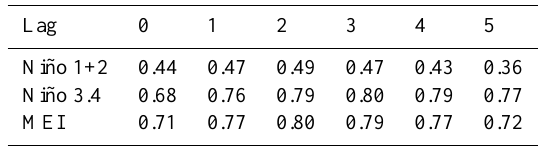
Table 4. Coefficient of determination ( r 2 ) between the computed annual MB 4750 and various ENSO indices, for lags between 0 and 5